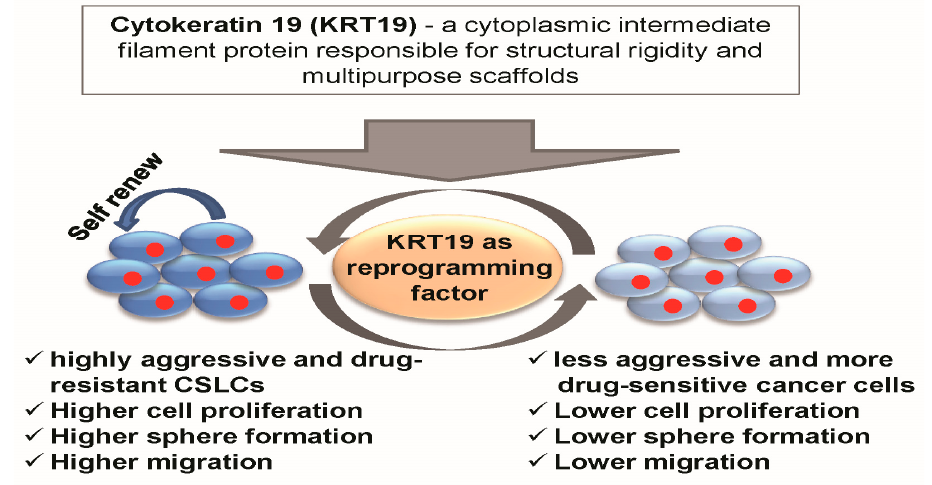
Figure 7. Schematic diagram demonstrating the KRT19 -mediated modulation of cancer reprogramming.